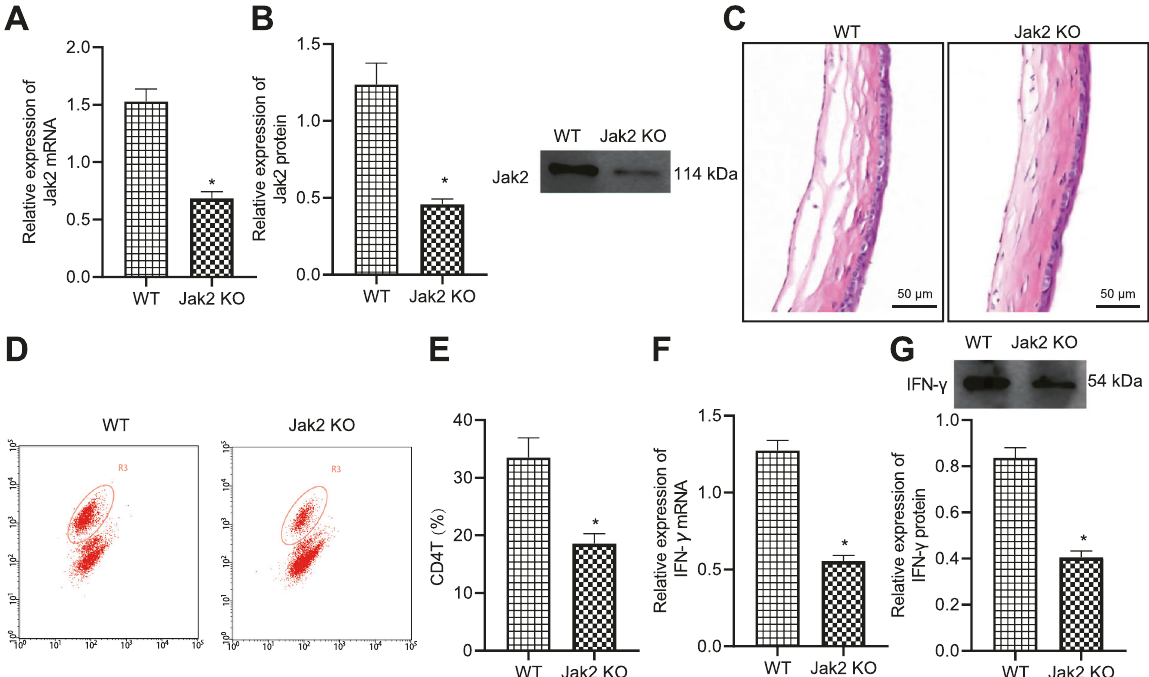
Fig. 3 JAK2 gene knockout prevents local corneal allograft rejection. A The mRNA expression of JAK2 in corneal grafts 14 days after the operation. B The protein expression of JAK2 in corneal allografts 14 days after the operation. C HE staining for mouse corneas 14 days after the operation, scale bar = 50 μ m. D The scatter plot for a percentage of CD4 + T cells in ipsilateral cervical lymph nodes of WT and JAK2 knockout mice 14 days after the operation. E The percentage of CD4 + T cells in ipsilateral cervical lymph nodes of WT mice and JAK2 knockout mice 14 days after the operation. F The mRNA expression of IFN- γ in corneal grafts of WT mice and JAK2 knockout mice 14 days after the operation. G The mRNA expression of IFN- γ in corneal grafts of WT mice and JAK2 knockout mice 14 days after the operation. * p < 0.05 vs. compared with WT